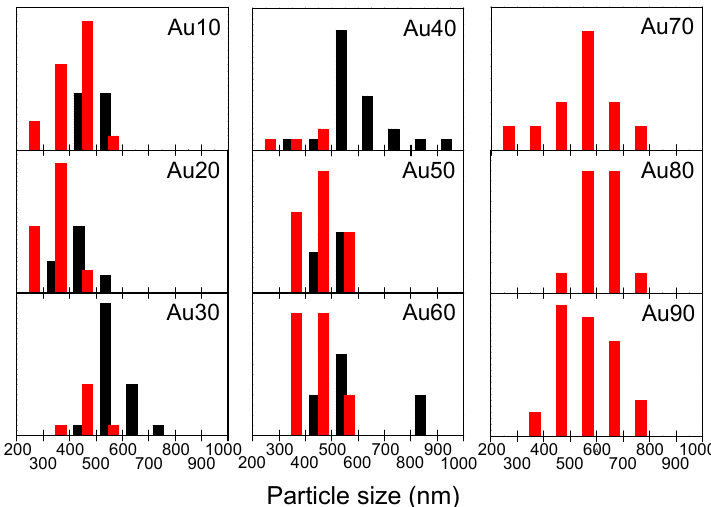
Figure 3. Size histograms of the particles obtained with different mixing ratios of the raw nanoparticle solution of Au and Fe 2 O 3 . “Au10” denotes Au 10%:Fe 90% in weight. The black and red bars indicate the frequencies of phase-separated and homogeneous submicrometre particles in every 100 nm step.